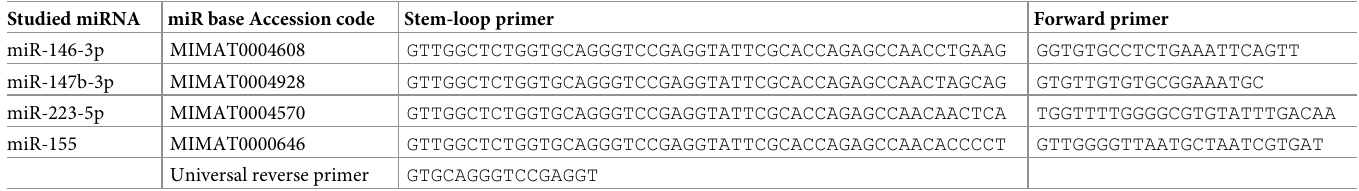
Table 1. Primer sequences used for real-time PCR to quantify the studied